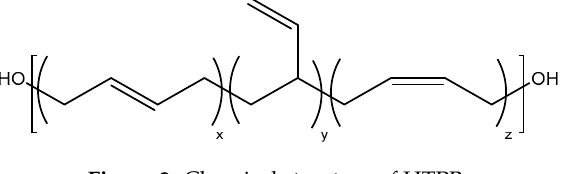
Figure 2. Chemical structure of HTPB.